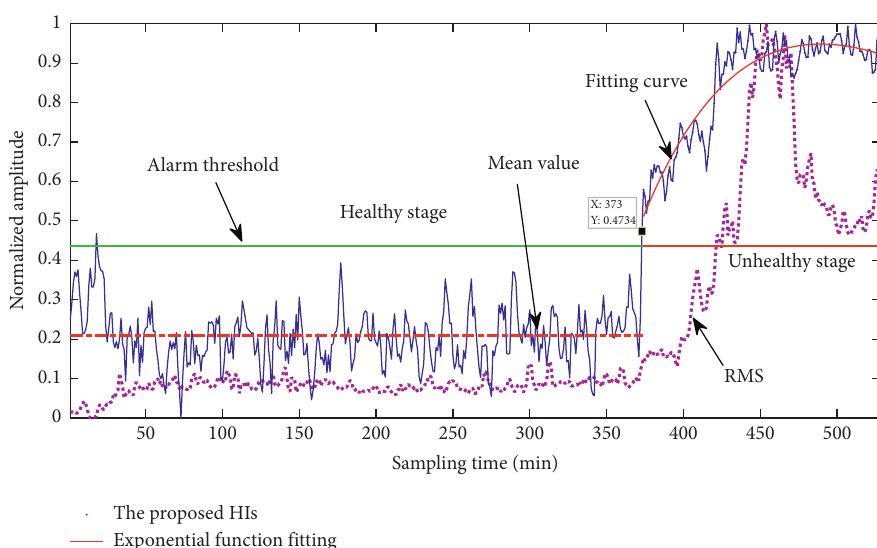
Figure 16: HS division for the proposed HIs based on the 3 σ alarm